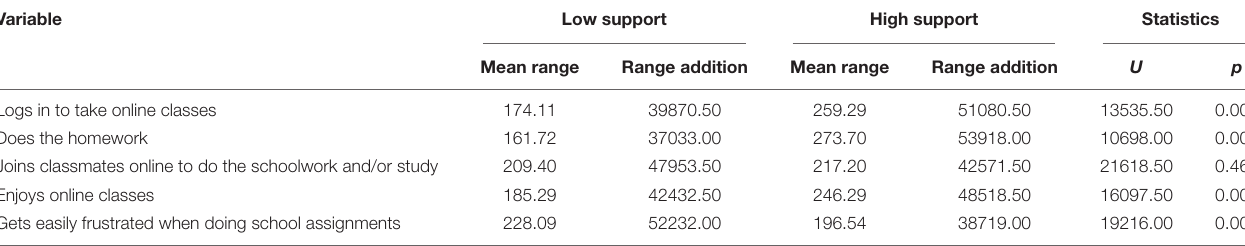
TABLE 6 | Change in children’s behavior according to the level of parental school